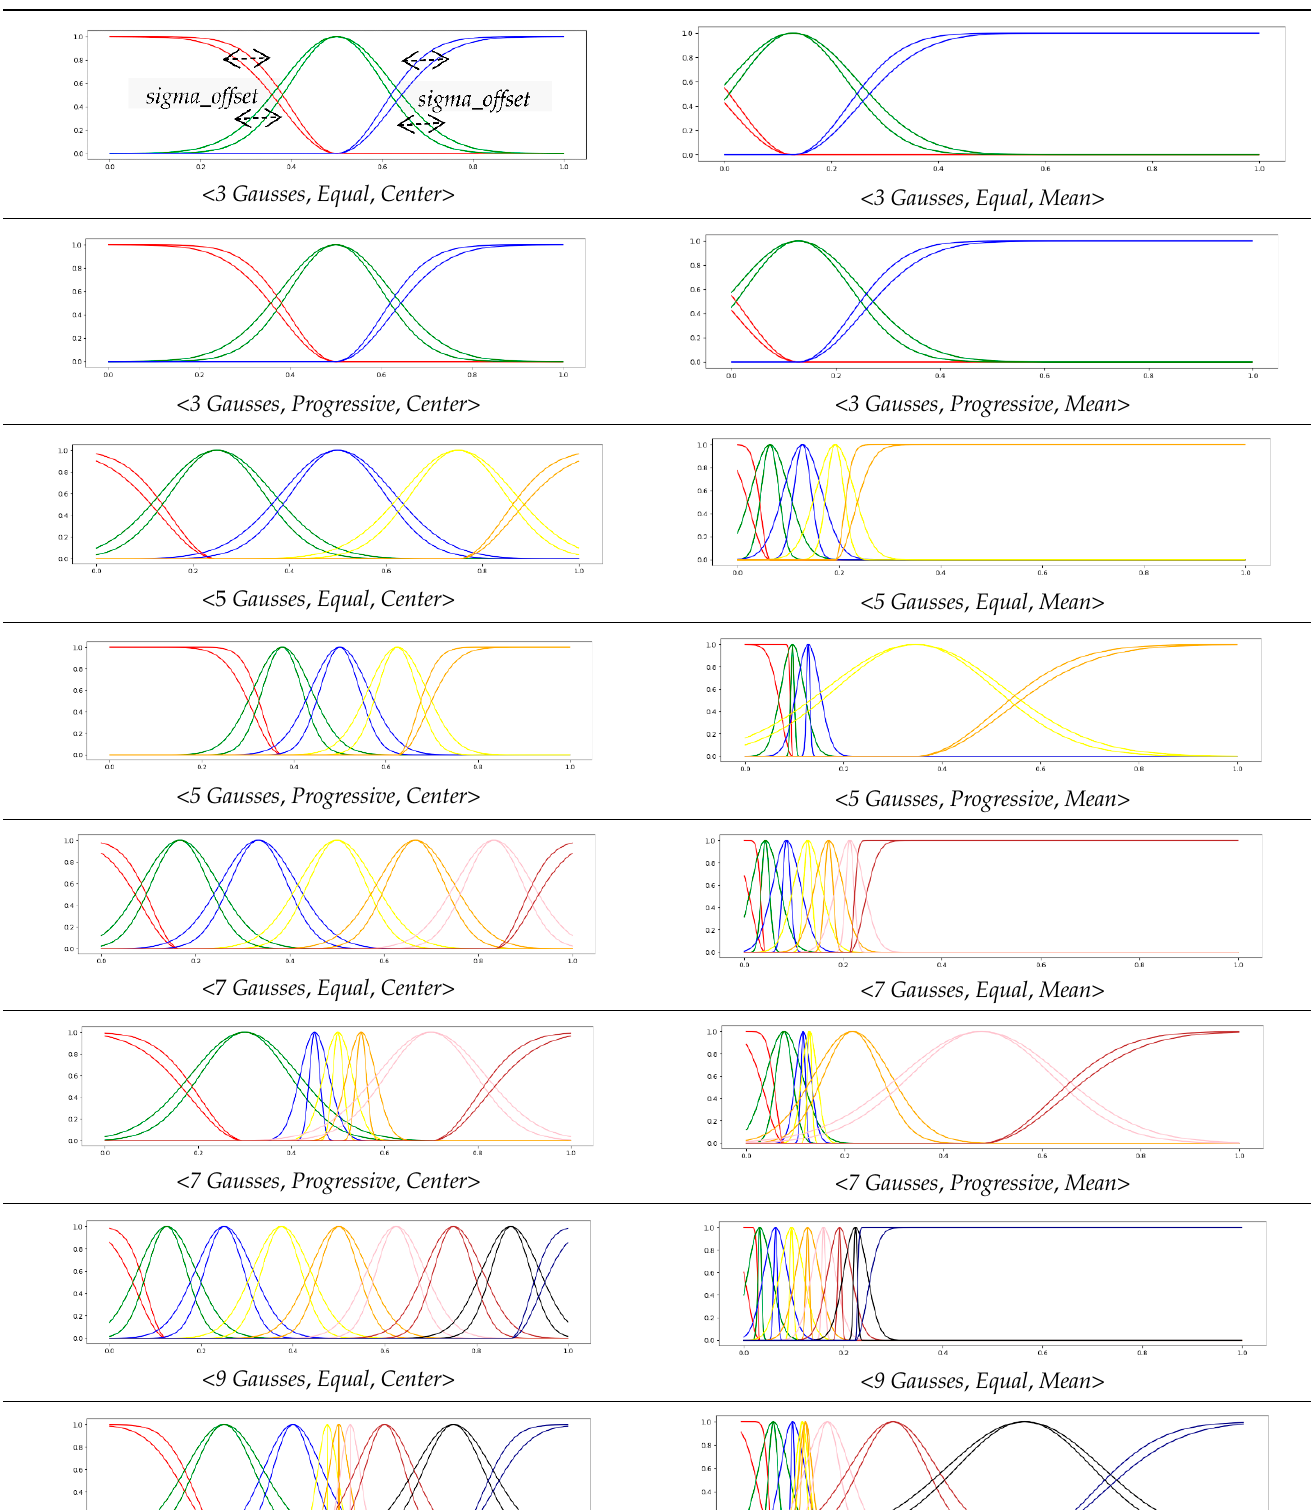
the medium function. Table 4. The IT2 fuzzy sets used for a sample attribute of the blood transfusion data set. For all attributes, we normalized Table 4. The IT2 fuzzy sets used for a sample attribute of the blood transfusion data set. For all attributes, we normalized the corresponding domain the corresponding domain values. Table 4. The IT2 fuzzy sets used for a sample attribute of the blood transfusion data set. For all attributes, we normalized Table 4. The IT2 fuzzy sets used for a sample attribute of the blood transfusion data set. For all attributes, we normalized the corresponding domain values. the corresponding domain values. Table 4. The IT2 fuzzy sets used for a sample attribute of the blood transfusion data set. For all attributes, we normalized Table 4. The IT2 fuzzy sets used for a sample attribute of the blood transfusion data set. For all attributes, we normalized Table 4. The IT2 fuzzy sets used for a sample attribute of the blood transfusion data set. For all attributes, we normalized the corresponding domain values. the corresponding domain values. Table 4. The IT2 fuzzy sets used for a sample attribute of the blood transfusion data set. For all attributes, we normalized Table 4. The IT2 fuzzy sets used for a sample attribute of the blood transfusion data set. For all attributes, we normalized the corresponding domain values. the corresponding domain values. the corresponding domain values.